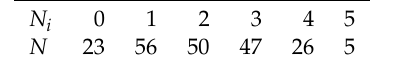
Table 4. The number graphs with N i isolated pentagons.